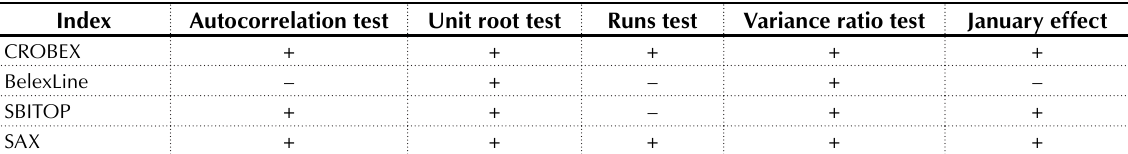
Table 6. All test result